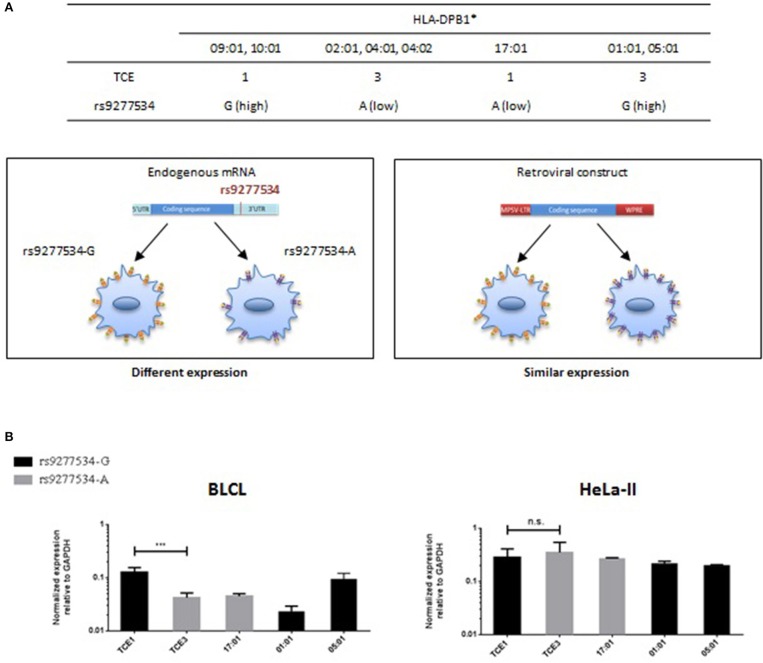
HLA-DPB1 transcriptional expression in BLCL or transduced HeLa-II in relation with rs9277534 and TCE groups. (A) The most frequent HLA-DPB1 alleles from TCE group 1 and 3 are linked with rs9277534-G and -A, respectively (16). Notable exceptions are HLA-DPB1*17:01 (TCE 1), HLA-DPB1*01:01 and HLA-DPB1*05:01 (both TCE 3), in which this association is inverted. Endogenous HLA-DPB1 expression is predicted to be genetically regulated by the rs9277534-G/A SNP in the 3′UTR, while this regulation is abrogated in cells transfected with the HLA-DPB1 coding region under a retroviral promoter in the absence of the 3′UTR. (B) Transcriptional expression of HLA-DPB1 in BLCL or transduced HeLa-II. HLA-DPB1 mRNA was quantified by RT-qPCR relative to GAPDH in BLCL homozygous for alleles from TCE 1 (rs9277534-G) or TCE 3 (rs9277534-A) (Table 1), or in HeLa-II after retroviral vector transduction with the same alleles. Shown are the mean results and SD from 3 independent experiments. Statistical comparisons were performed by the two-tailed unpaired t-test (***p < 0.001).